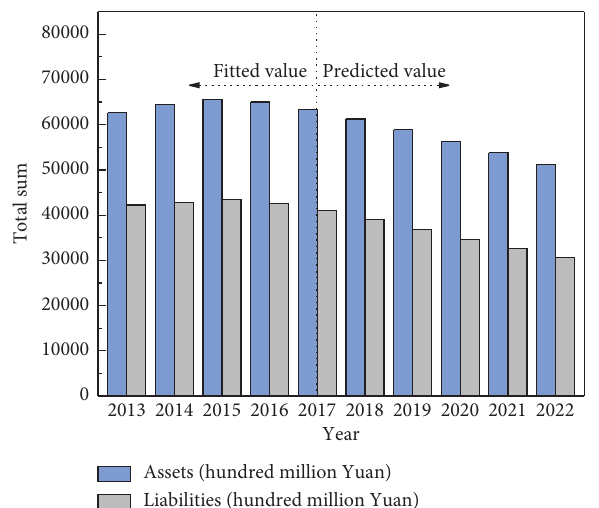
Figure 4: Model calculation results for FRI’s assets and liabilities.